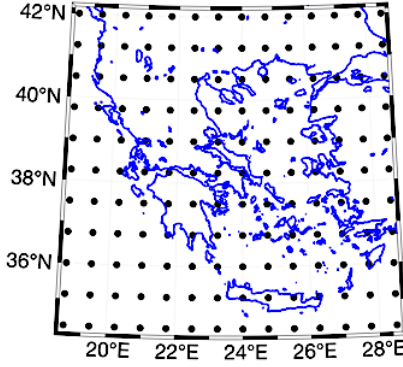
Figure 1. The area of study and the ERA-Interim reanalysis grid points.